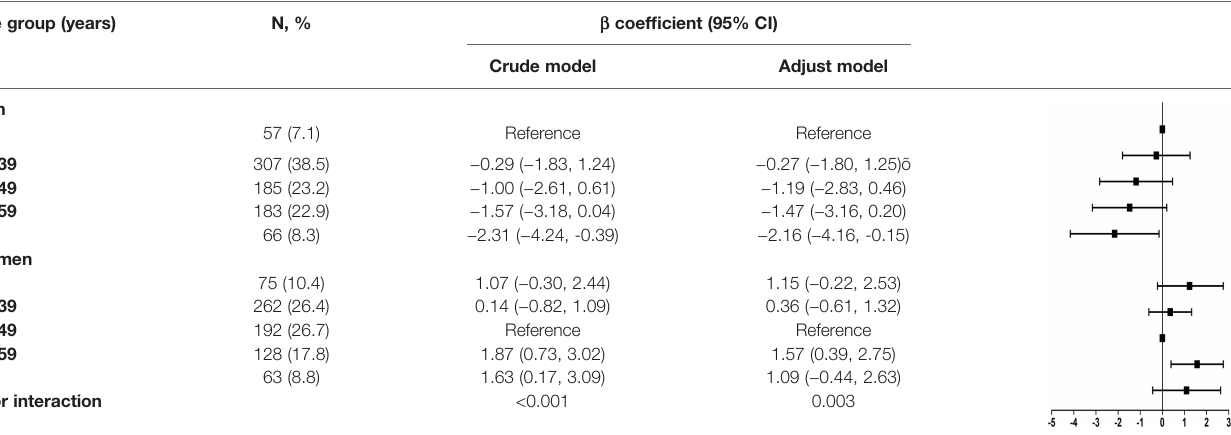
TABLE 3 | Strati fi ed analysis by